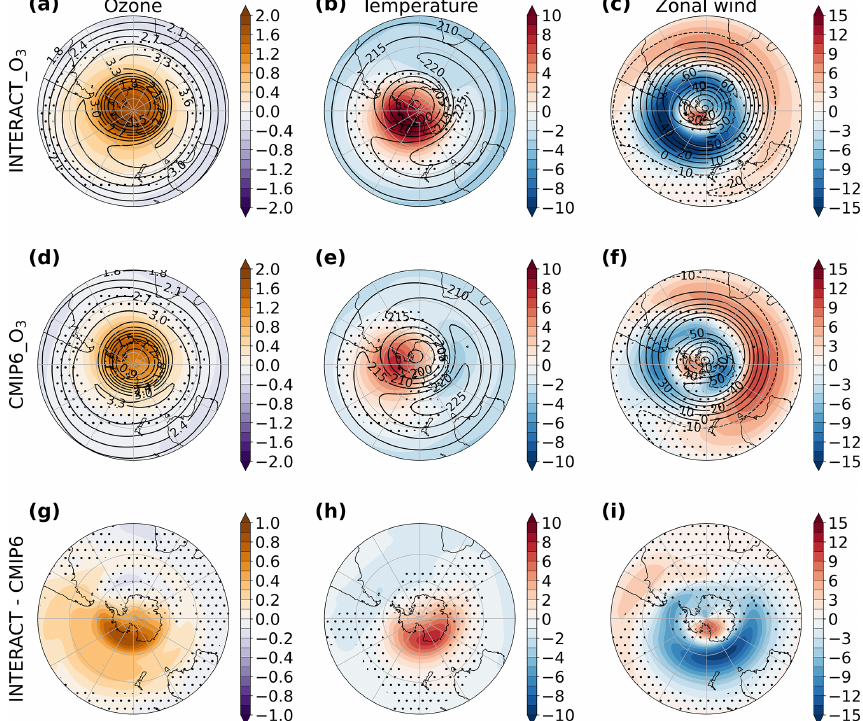
Figure 6. Changes in ozone ( a , d ; ppmv) and temperature ( b , e ; K) at 50hPa and in zonal wind ( c , f ; ms − 1 ) at 20hPa due to ODSs and GHGs combined, in INTERACT_O 3 (a–c) and in CMIP6_O 3 (d–f) , and the difference between the INTERACT_O 3 and the CMIP6_O 3 changes (g–i) . The stippling in (a) – (f) masks regions where the changes are not significant at the 95% confidence interval based on a two- tailed t test, and the stippling in (g) – (i) masks regions where the difference is lower than 2 σ inferred from the spread of the individual ensemble members. The contours in (a) – (f) show the current-day (2011–2030) climatologies in the respective